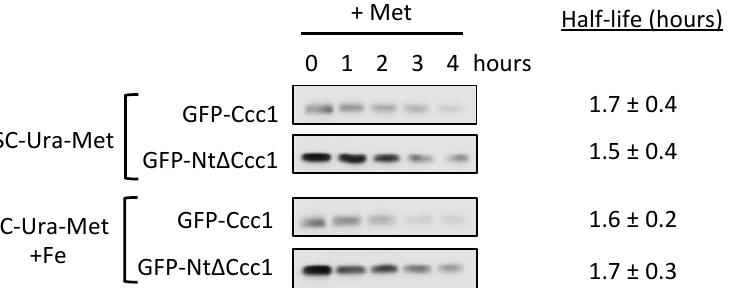
Figure 5. GFP-Ccc1 and GFP-Nt ∆ Ccc1 protein stability in normal and high-iron conditions. Yeast ccc1 ∆ cells transformed with either pUG36-CCC1 ( P MET17 -GFP-CCC1 ) or pUG36-Nt ∆ CCC1 ( P MET17 - GFP- Nt ∆ CCC1 ) plasmids were cultivated in SC-Ura-Met to exponential phase and 3 mM FAS was added (or not) for 1 h. Expression was stopped by addition of 3 mM methionine, and aliquots were isolated at the indicated time points. Total proteins were extracted, and Ccc1 protein levels were determined by immunoblotting with anti-GFP antibody. Equal amounts of total proteins were loaded in each lane. Three independent biological experiments were performed, and GFP-Ccc1 and GFP-Nt ∆ Ccc1 protein half-lives was determined. The average half-life and its standard deviation are